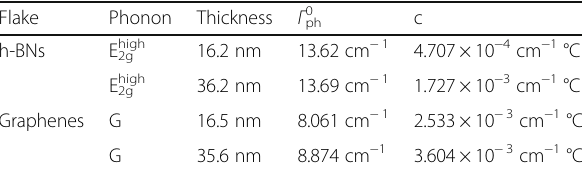
temperature range from − 194 to 200 °C. The frequency